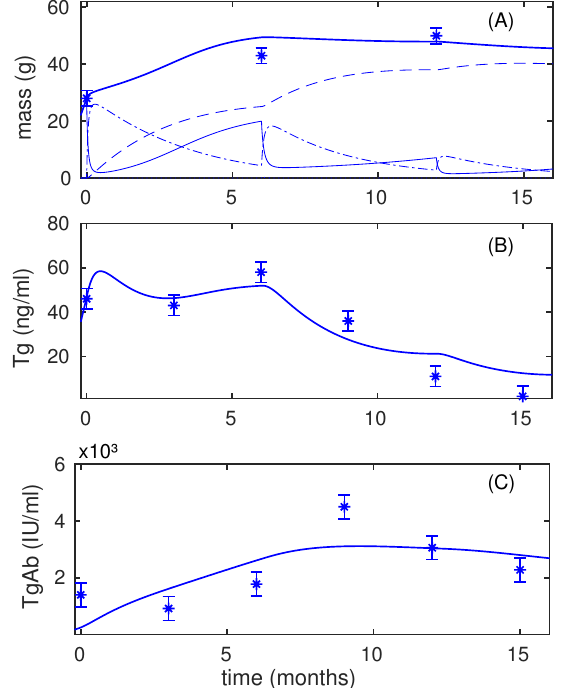
Figure 4. Evolution of DTC local recurrence with time for a 131 I treatment consisting of three administrations of 7400 MBq each. Experimental measurements, represented by asterisks with error bars, and best fits obtained with the model. ( A ) Tumor mass: total indicated by a thick solid line; masses corresponding to undamaged cells by a thin solid line; doomed cells by a dash–dot line; and dead cells by a dashed line. ( B ) Total Tg concentration. ( C ) TgAb concentration.